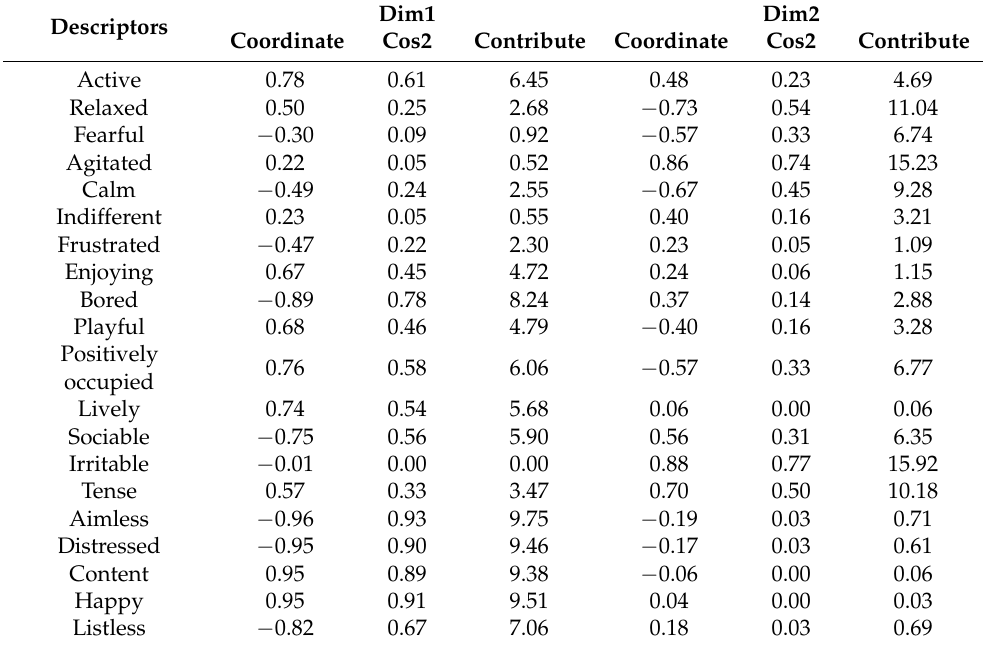
Figure 2. Qualitative behavior assessment (QBA) analysis performed on the pigs. The QBA was performed following the indications of the Welfare Quality [23]. Descriptors and factors were analyzed using principal component analysis. The results of Dim1 (Principal component dimension 1) and Dim2 (Principal component dimension 2) are reported. One spot corresponded to one observation. The color of the spot indicates the observation: T1 (yellow, indicating pigs of 40 kg on average); T2 (pink, pigs of 100 kg of average); T3 (red, pigs of 160 kg on average). The shape of the spot corresponds to the building: square = pigs raised in naturally ventilated building; circle = pigs raised in the mechanically ventilated building. Table 3. Eigenvalue (Coordinate), quality of the representation (Cos2) and contribute of the descriptors (Contribute) used in the Qualitative Behavior Assessment.